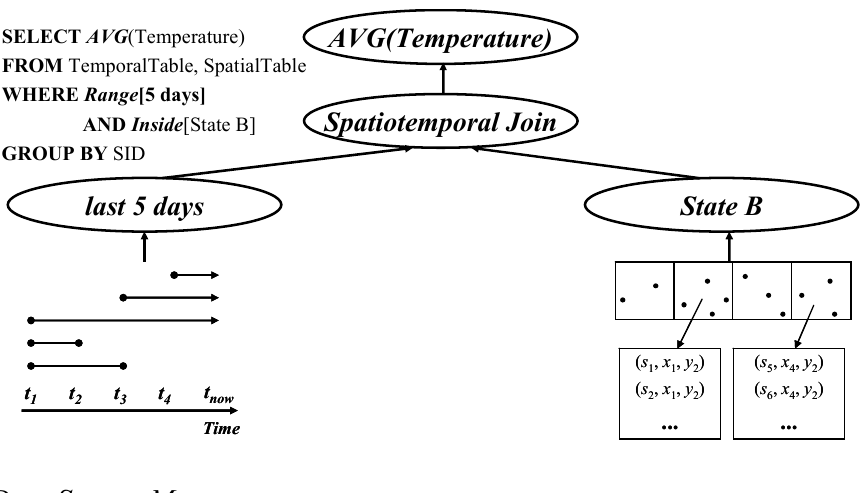
Figure 6. Spatiotemporal historical query join